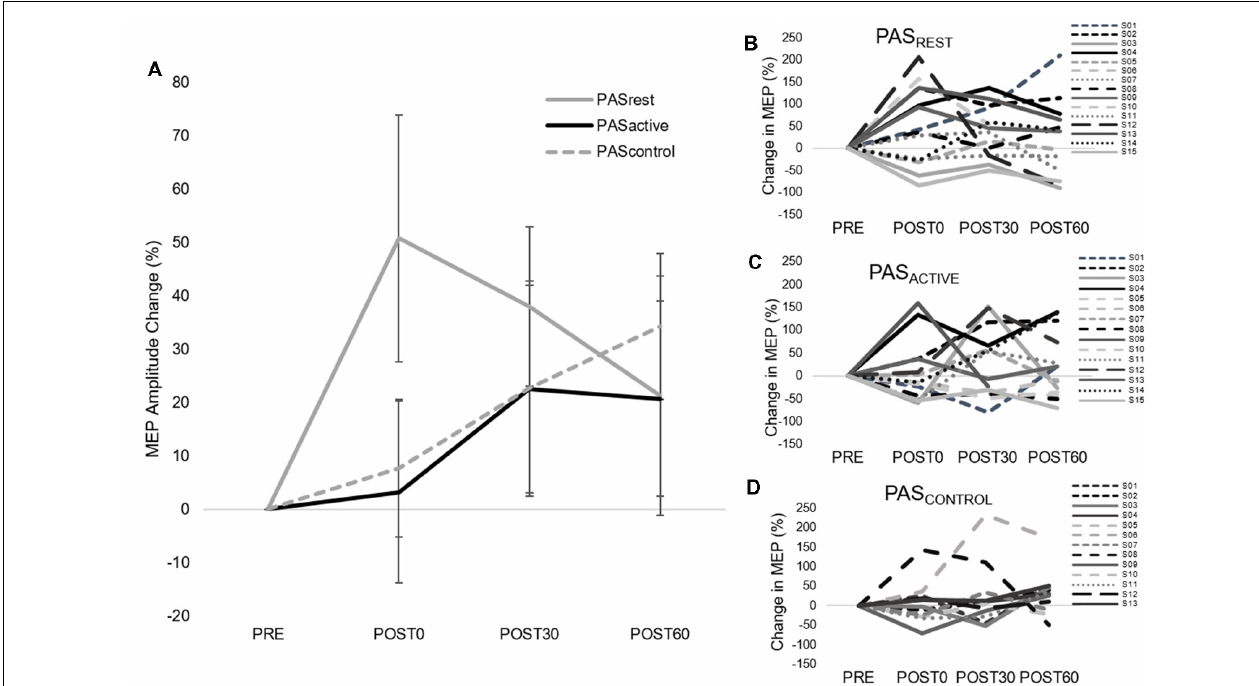
FIGURE 2 | Group (left) and individual (right) motor-evoked-potential (MEP) amplitude (mean ± SE) during single-pulse 1 mV transcranial magnetic stimulation (TMS) assessment. (A) Average MEP amplitude change for each PAS condition. (B–D) Individual MEP amplitude change for each PAS condition. There was no condition-by-time interaction ( F ( 4,14 ) = 1.12, p = 0.36) or main effects of PAS condition ( F ( 2,14 ) = 1.17, p = 0.33) or time ( F ( 2,14 ) = 1.59, p = 0.21).